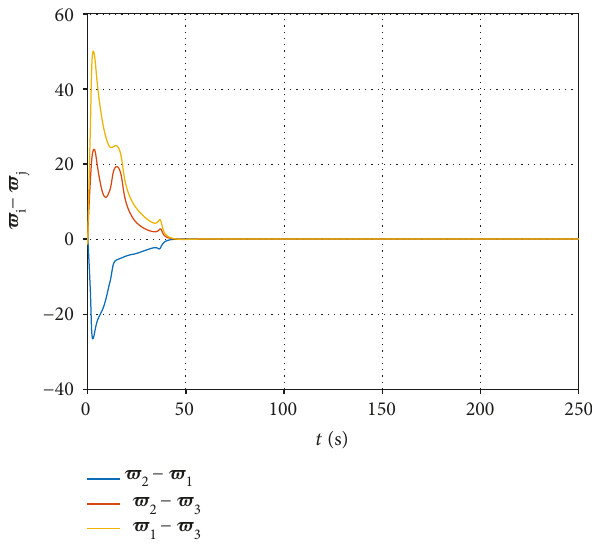
Figure 8: System coordinate path parameters error evolution-circle